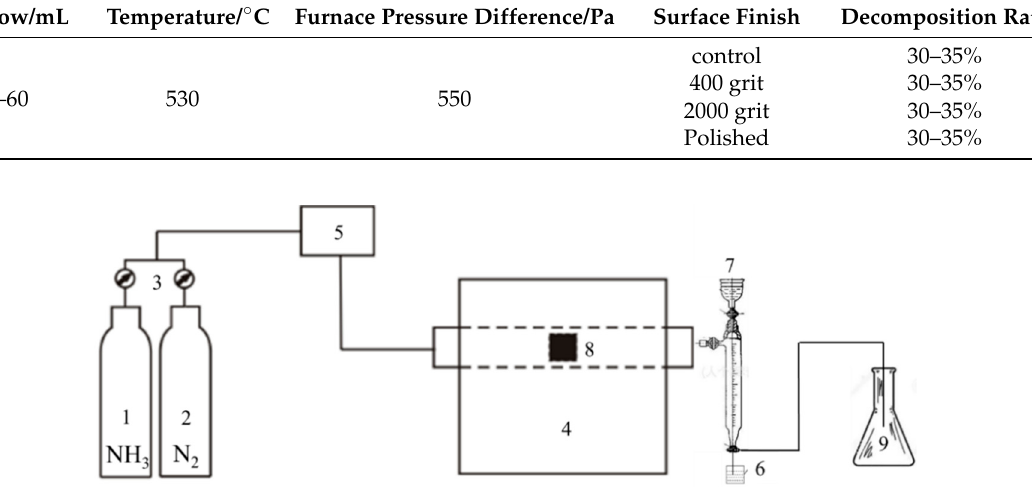
Figure 2. Diagram of gas nitriding. 1. Ammonia cylinder; 2 nitrogen cylinder; 3. pressure